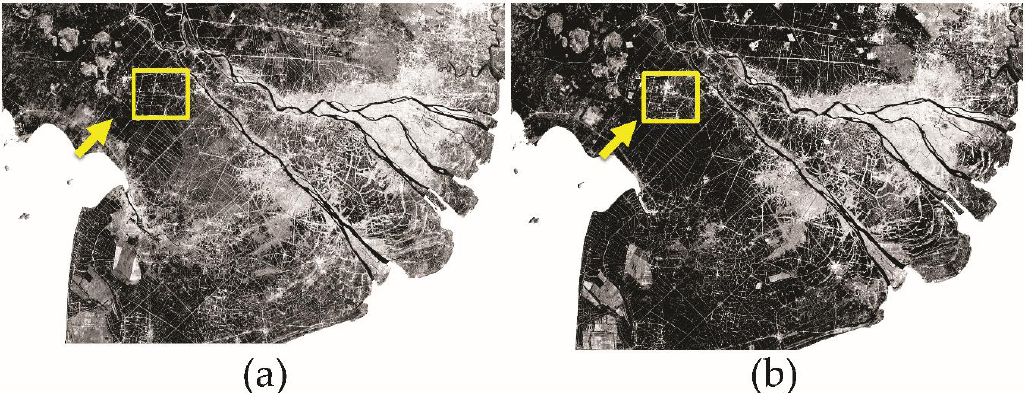
Figure 9. Two samples of ALOS-2/PALSAR-2-ScanSAR data of the HH microwave backscattering coefficient showing the Mekong Delta on 10 April 2015 (dry season) ( a ) and 23 October 2015 (flooding season) ( b ). One of the areas where the intense backscattering was detected during the flooding season is enclosed with a yellow open box.